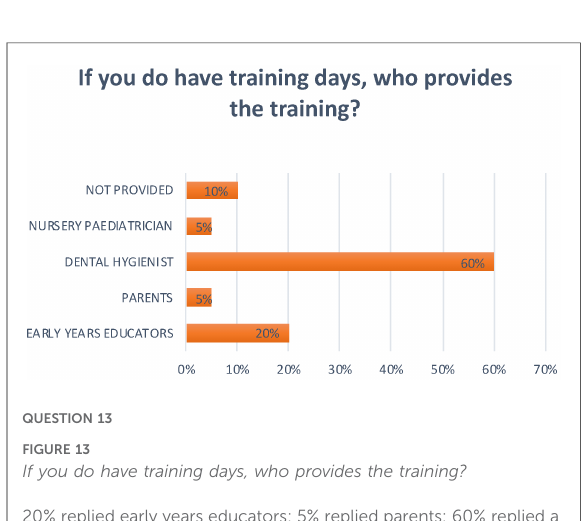
FIGURE 13 If you do have training days, who provides the training?